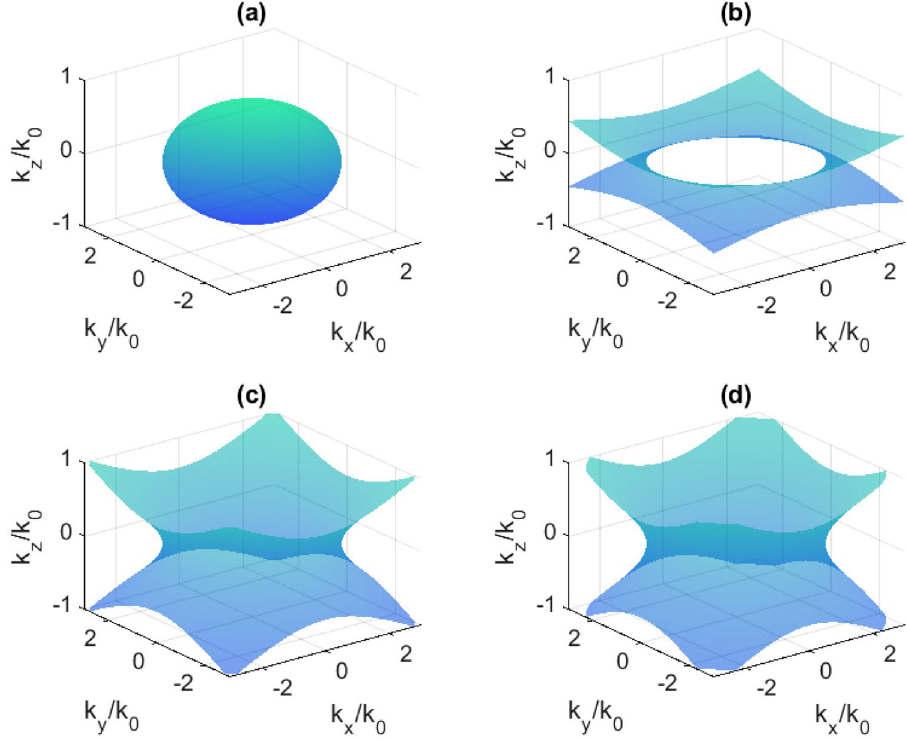
Figure 8. Isofrequency surfaces at 0.635 THz: ( a ) without pumping; ( b ) at 200 mW; ( c ) 400 mW; ( d ) 600 mW.